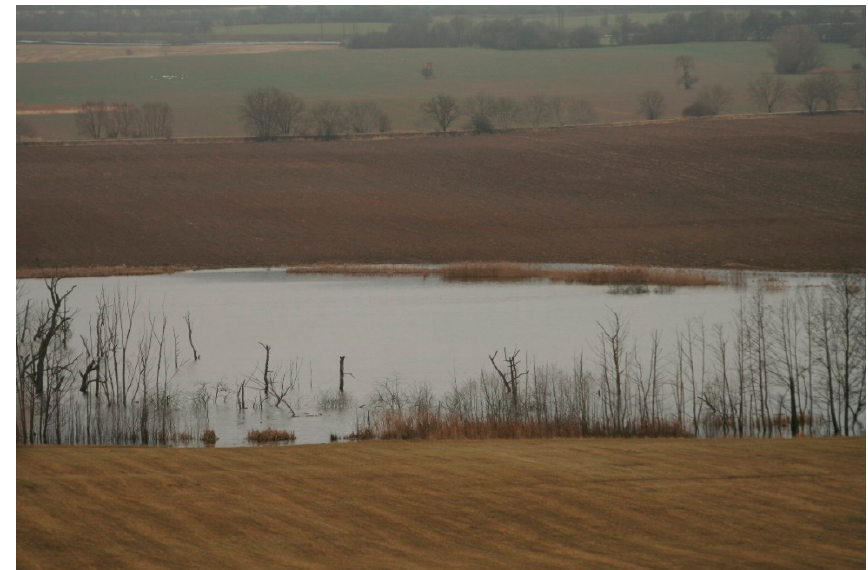
Figure 5. The process of wetland formation is still ongoing.